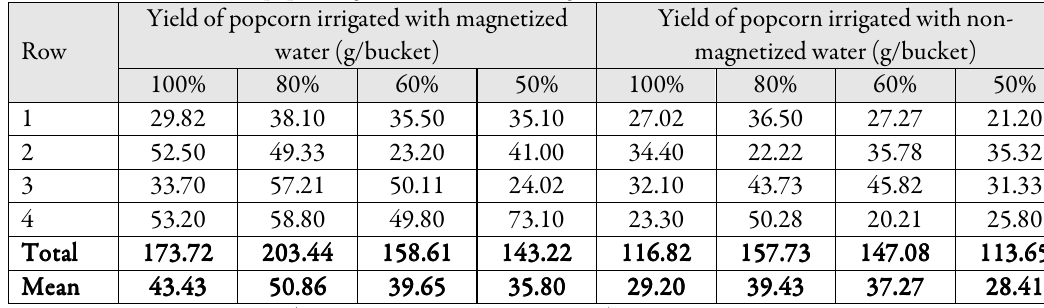
Table 5. Yield of the popcorn (grains only) after shelling